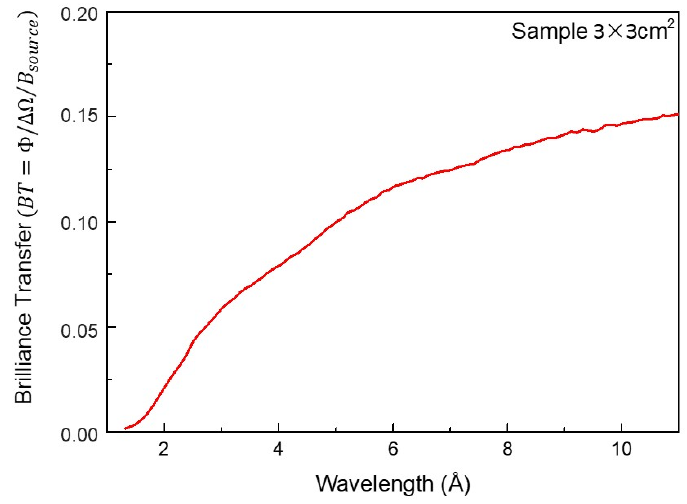
Figure 12. Brilliance transfer at the wavelength range of interest.